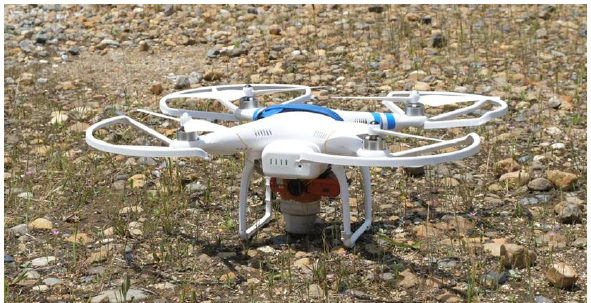
Figure 9. Mounting camera to UAV.